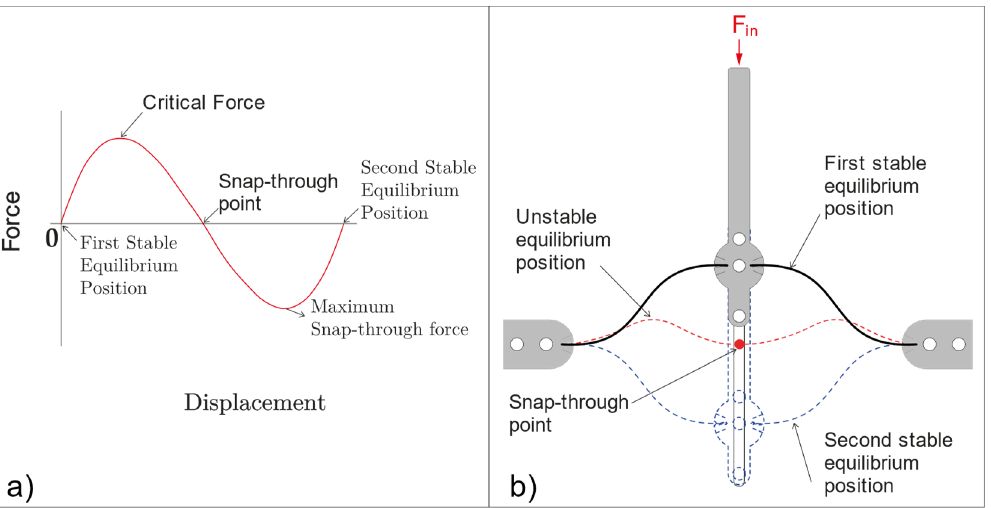
Figure 1. ( a ) Typical bi-stable force-displacement graph. ( b ) Stable and unstable equilibrium posi- tions of the bi-stable mechanism used in this study. of the bi-stable mechanism used in this